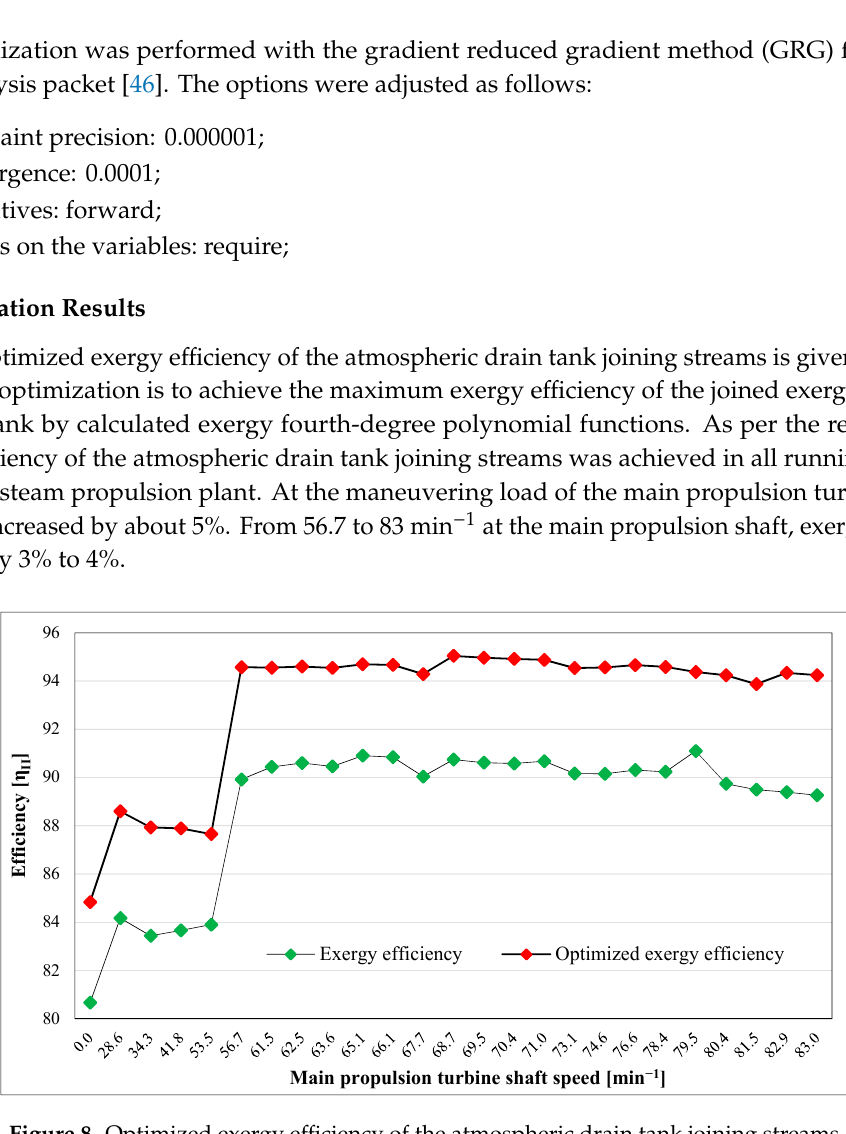
Figure 8. Optimized exergy efficiency of the atmospheric drain tank joining streams.